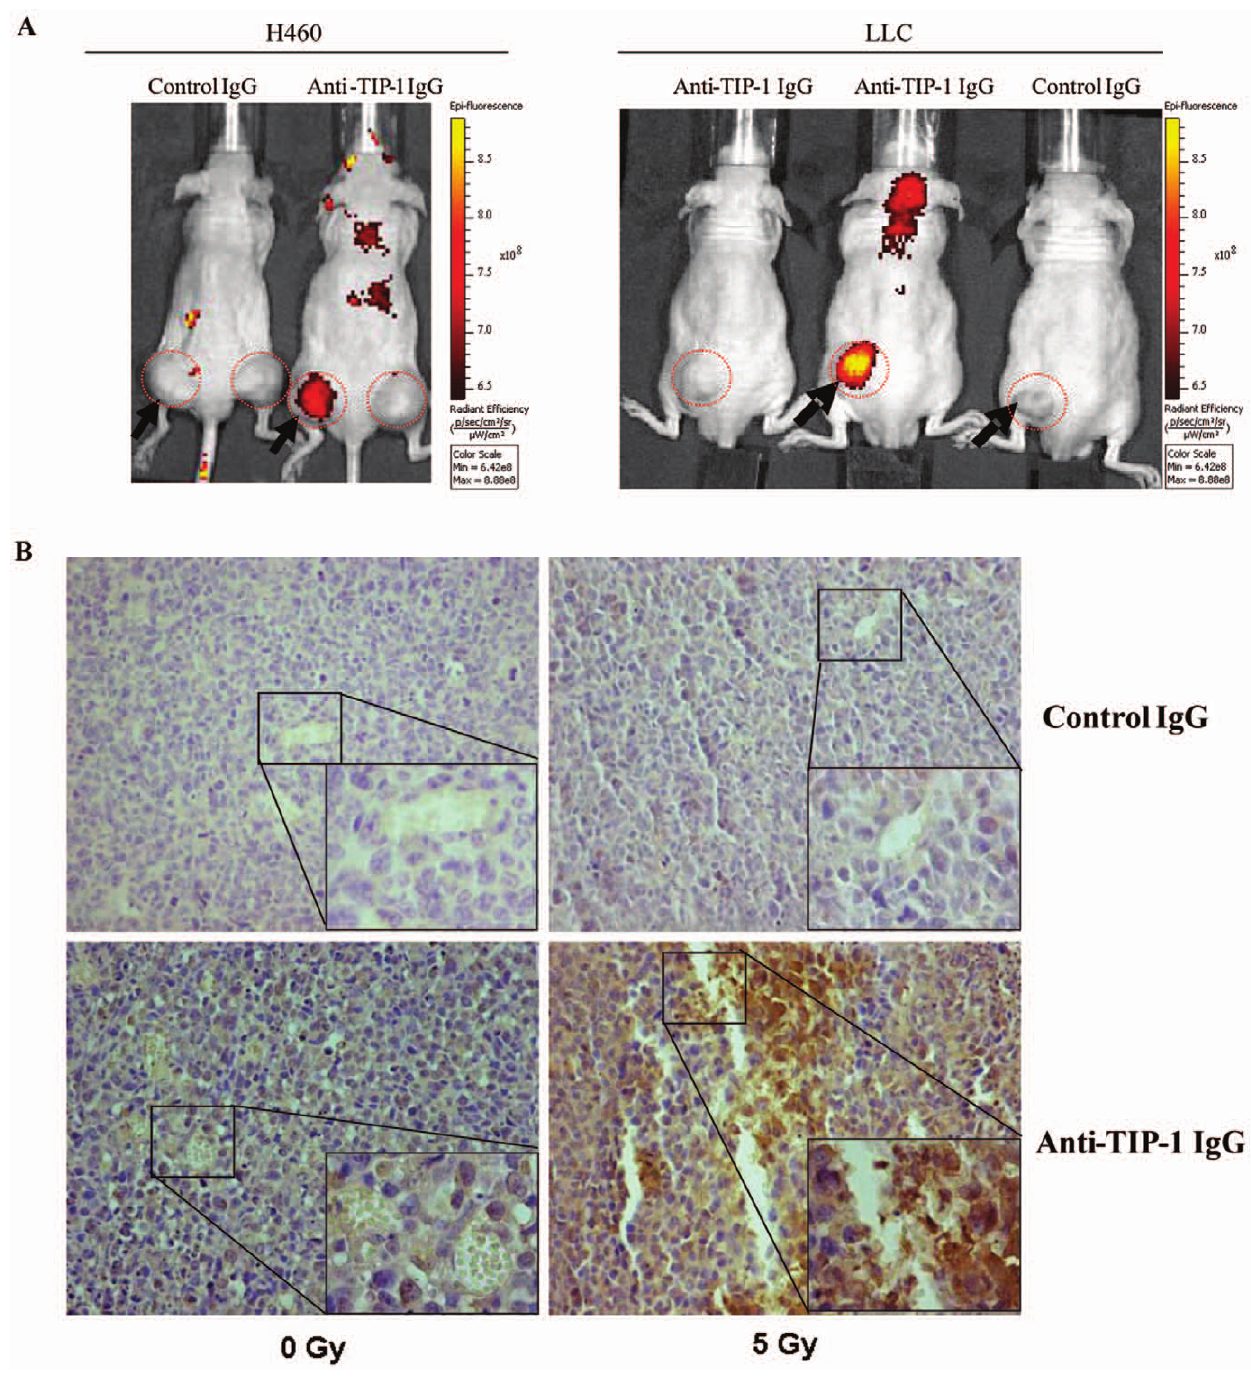
Figure 3. TIP-1 specific antibody was selectively homed to the irradiated tumors. A : NIR images of the TIP-1 antibody distribution within tumor-bearing mice. H460 and LLC tumors were developed in hind limbs of nude mice, respectively. Tumors were indicated within the dashed circles. The irradiated tumors (at 5 Gy) were pointed with arrows. Alexa Fluor 750-labeled control or TIP-1 specific antibodies were injected 4 hours after the irradiation. The showed representative optical images were acquired 24 hours after the antibody injection. B : Immunohistochemical staining of the intravenously administrated antibodies within the irradiated tumors. The imaged tumors were retrieved for detection of the antibodies within the tumors. The antibodies (rabbit IgGs) were detected with HRP-conjugates and visualized with DAB (shown as brown). Hematoxylin (blue) was used for counterstaining. Representative images from H460 tumor sections were presented, high magnification (x400) images were shown as inserts. doi:10.1371/journal.pone.0012051.g003 surface. A similar effect of radiation on the TIP-1 expression on the H460 cancer cells (Fig. 4F). These data suggested that radiation cell surface were also observed on the LLC cells, but not the HUVEC induced translocation of the intracellular TIP-1 onto the plasma cells even the endothelial cells had been co-cultured with LLC or membrane might be limited to cancer cells.